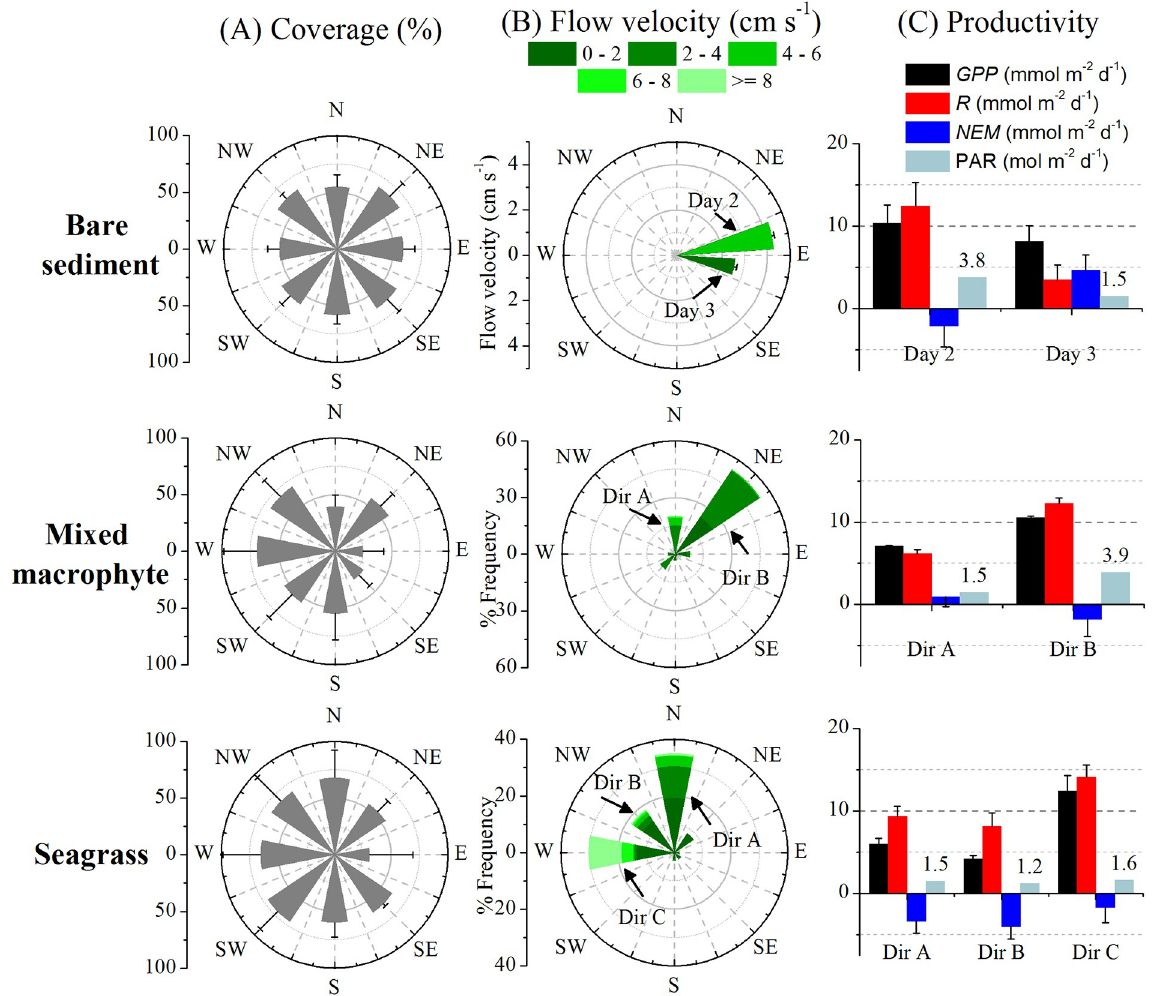
Fig 6. Windrose plots (mean ± SD) for the soft-sediment sites. (A) Coverage (ArcMap, see section 2.7.) of benthic microalgae ( i . e ., chlorophyll a), macrophytes, and seagrass, (B) directional flow velocity distribution, and (C) daily seafloor productivity rates for different days or different directions (daily integrated PAR values are